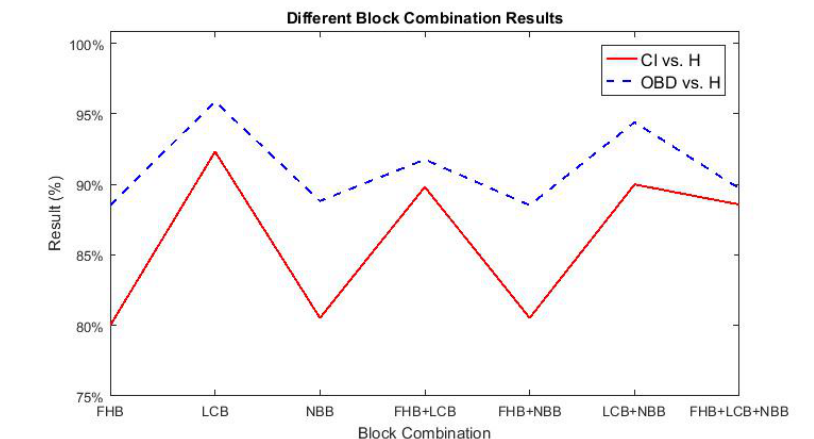
Figure 14. Different block combination results of BD sub-classes vs. H.